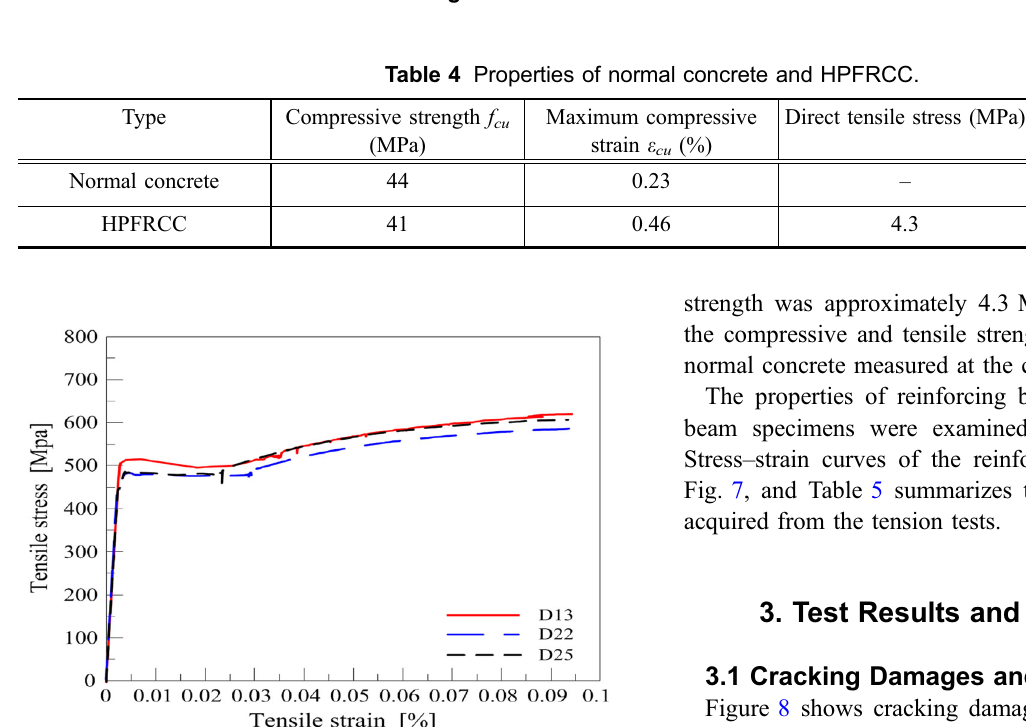
Fig. 6 Stress-strain curves of concrete